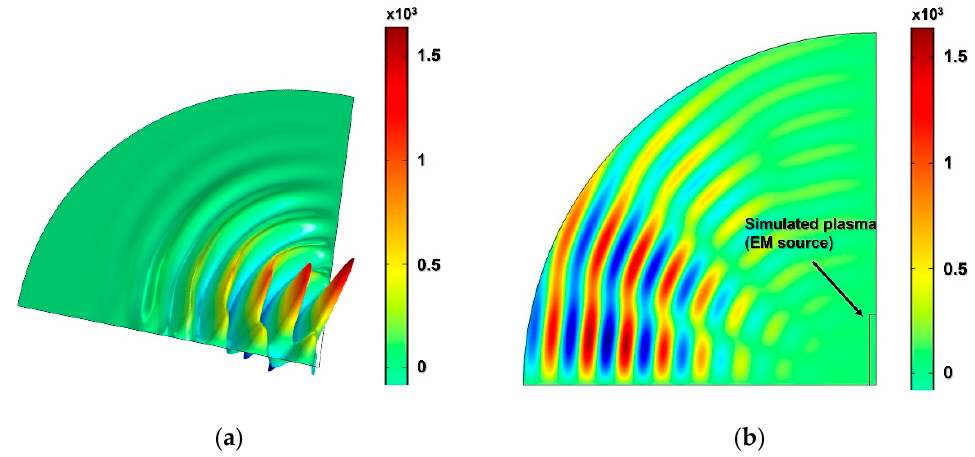
Figure 10. ( a ) Position of the electric field source and detector in the simulation. ( b ) Two-dimensional view of electric field propagation in the quadrant.